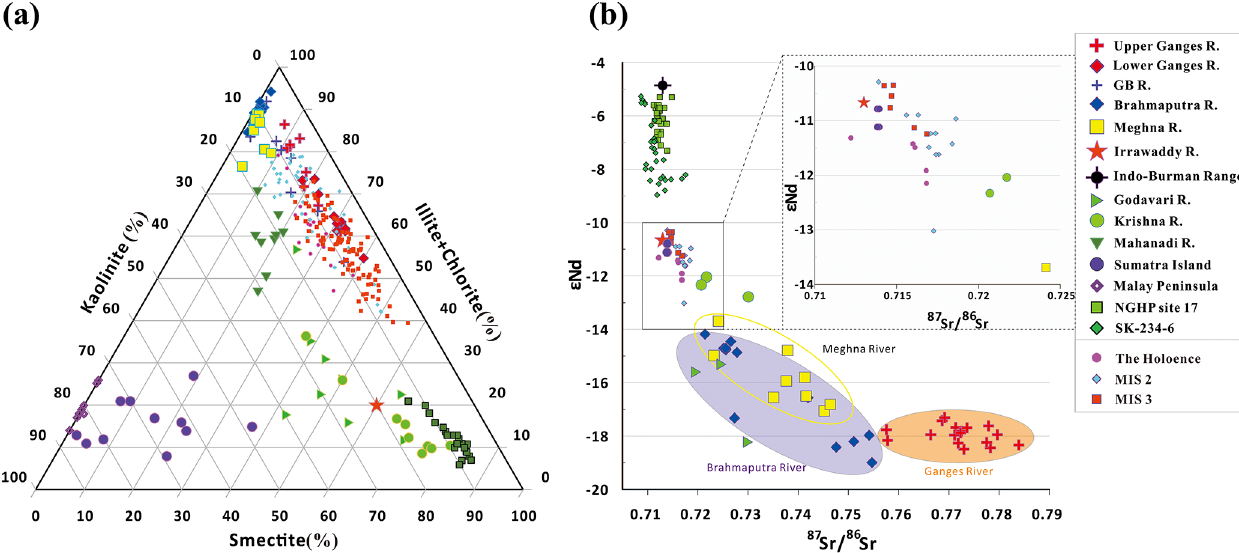
Figure 4. Sediment provenance of core 17I106 in the northeastern Indian Ocean. (a) Sediment provenance discrimination diagram in the northeastern Indian Ocean. For comparison, clay mineral data obtained from sediments collected in the modern Ganges River, Brahmaputra River lower, Ganges–Brahmaputra River lower and Meghna River (Khan et al., 2019), Mahanadi and Krishna rivers on the Indian Peninsula (Bejugam and Nayak, 2017), Irrawaddy River (Rodolfo, 1969), and Sumatra and Malay Peninsula rivers (Liu et al., 2012) are also plotted. The referenced cores comprise NGHP Site 17 (Ali et al., 2015), representing the Irrawaddy River as the main clay mineral source in the Andaman Sea. (b) Variations in ε Nd (0) vs. 87 Sr / 86 Sr measured in core 17I106 compared with those measured in river sediments and bulk rock samples collected around the BoB. In this diagram, we display data collected from Indian river samples (from the Godavari and Krishna rivers) (Ahmad et al., 2009) from different parts of the modern G-B River system (Lupker et al., 2013). Measurements taken from sediments obtained from the Irrawaddy River (Colin et al., 1999), formations from the Indo-Burman ranges (Licht et al., 2013), and volcanic products of Sumatra (Turner and Foden, 2001) are also plotted. The referenced cores include NGHP Sites 17 and SK-234-60, both of which indicate that the Irrawaddy River is the main Sr–Nd isotope source for the Andaman